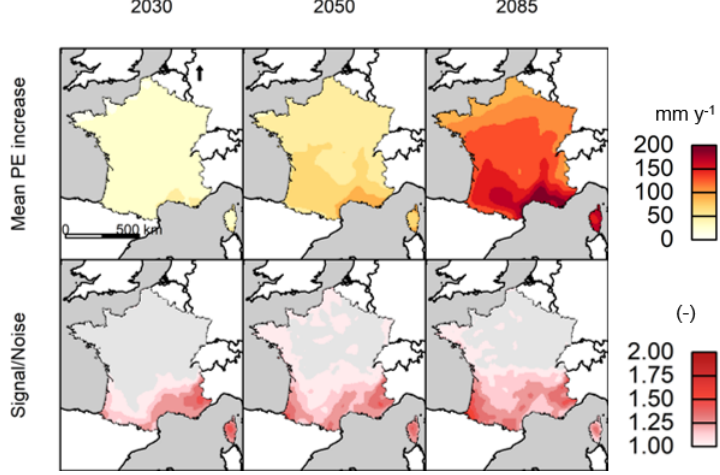
Figure 7. The top row shows the mean change in annual PE (mmy − 1 ) computed with the QUALYPSO framework, the bottom row presents the signal-to-noise ratio. Results are shown for three different 30-year periods centered around 2030, 2050 and 2085. Gray areas indicate a signal-to-noise ratio below 1 at the 90% confidence bounds, whereas red areas show ratios above 1.